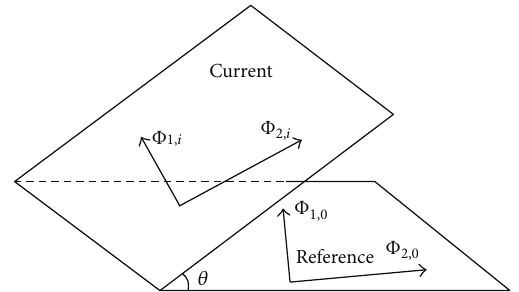
Figure 1: Angle 𝜃 formed by active subspaces according to the reference and current states, due to a dynamic